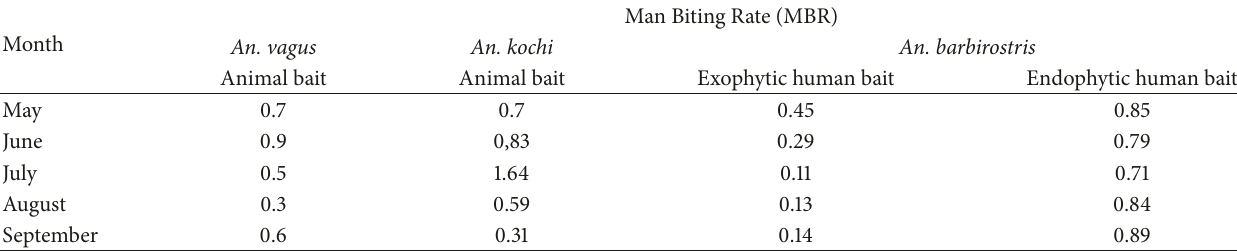
Table 2: Man Biting Rate (MBR) of An. vagus , An. kochi , and An. barbirostris .